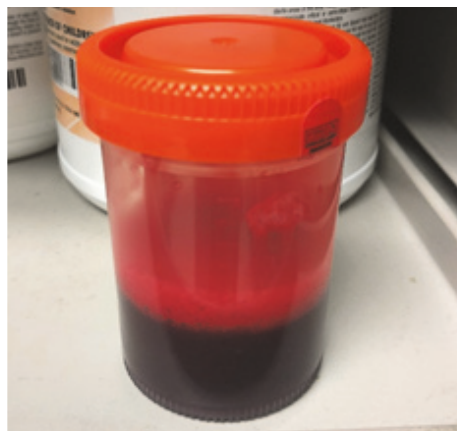
Figure 1: Large Left-Sided pleural effusion with tracheal deviation tothecontralateralside.Alsosternalwiresfrompreviousopen-heart surgery are noted.